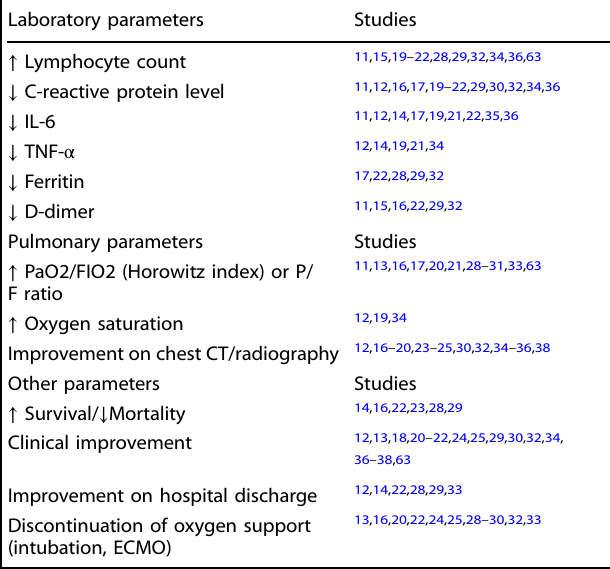
Table 3. Main outcomes and evaluated